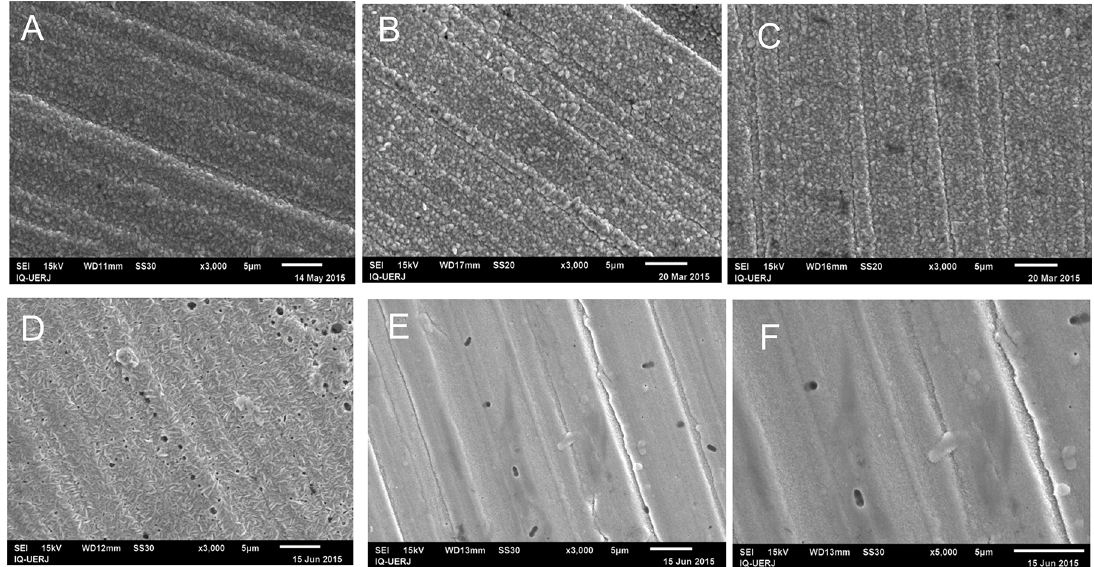
Figure 3. SEM morphological characterization of the coatings produced using Solution 1 (A, D) and Solution 2 (B, C, E) under the conditions described in Table 1: (A, B) Experiment 1; (C) Experiment 2; (D, E) Experiment 3. (F) Magnification of Figure